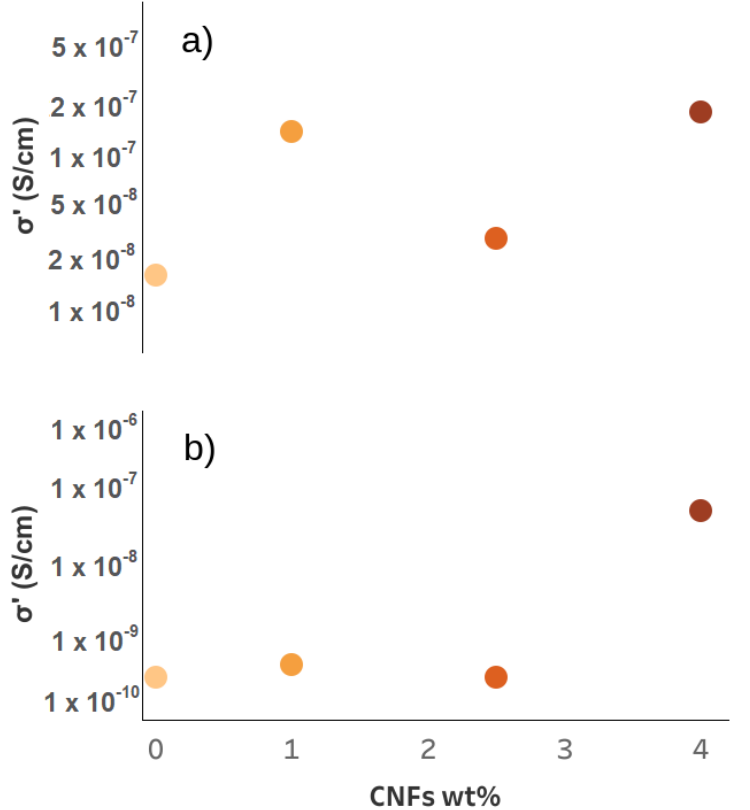
Figure 7. Electrical conductivity at 100 Hz as a function of CNF dosage at 30 ◦ C ( a ) and 160 ◦ C ( b ) (Gradient from yellow to dark red refers to CNFs